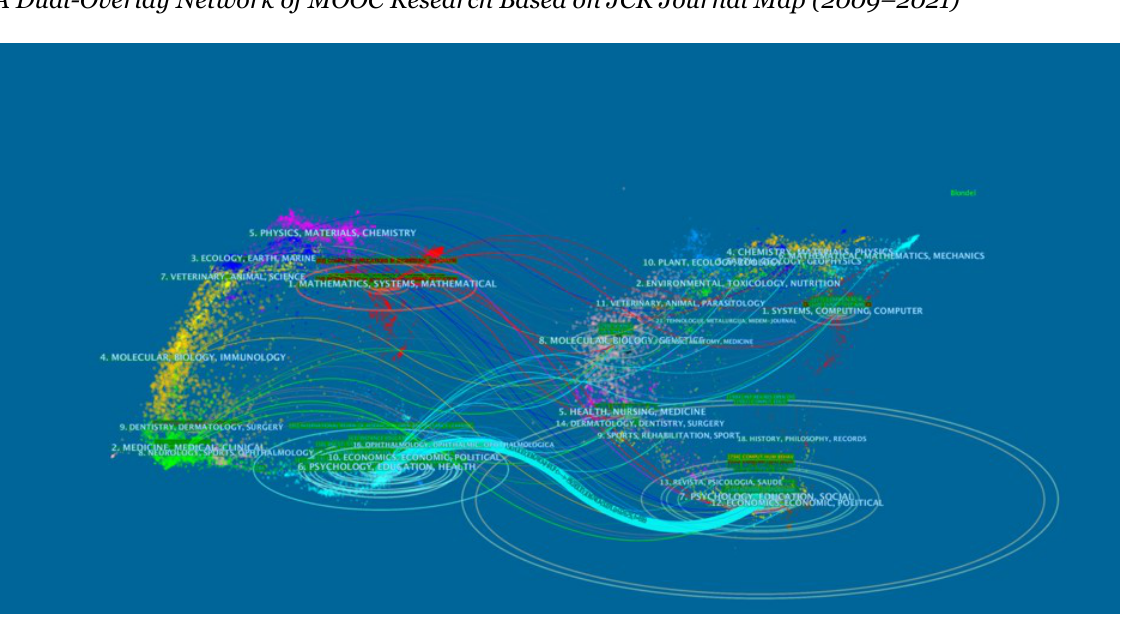
Figure 4 maps the subject areas of MOOC research. Each node represents the research subject classified by CiteSpace, based on WOS and Scopus classifications. The left side depicts the base map of citing journals, while the right is the base map of cited journals. The colorful lines between the two maps represent the